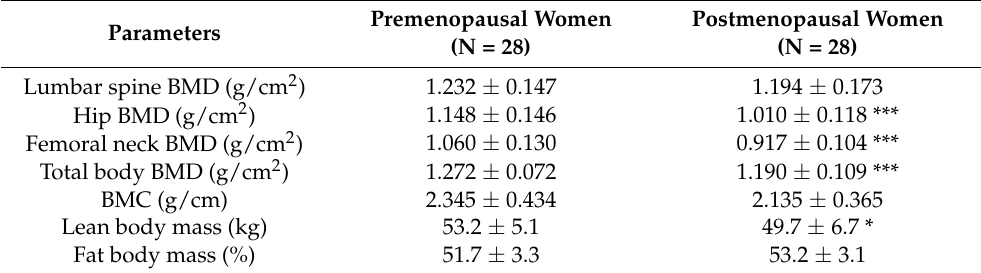
Table 3. Dual X-ray absorptiometry (DXA) parameters measured in the study groups. Significance was calculated by two-tailed unpaired Student’s t -test. For significance: * p < 0.05; *** p < 0.001.